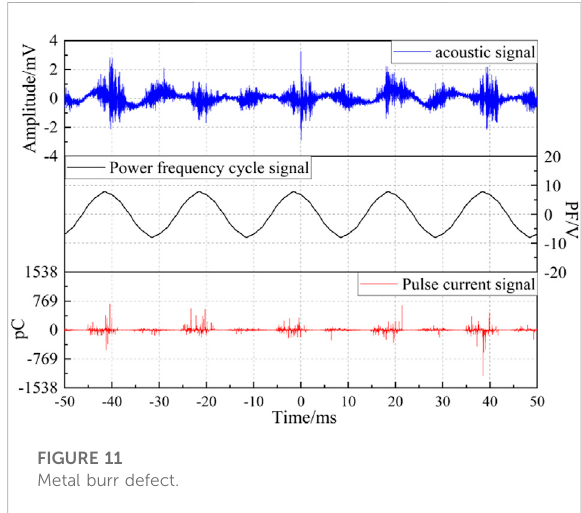
FIGURE 11 Metal burr